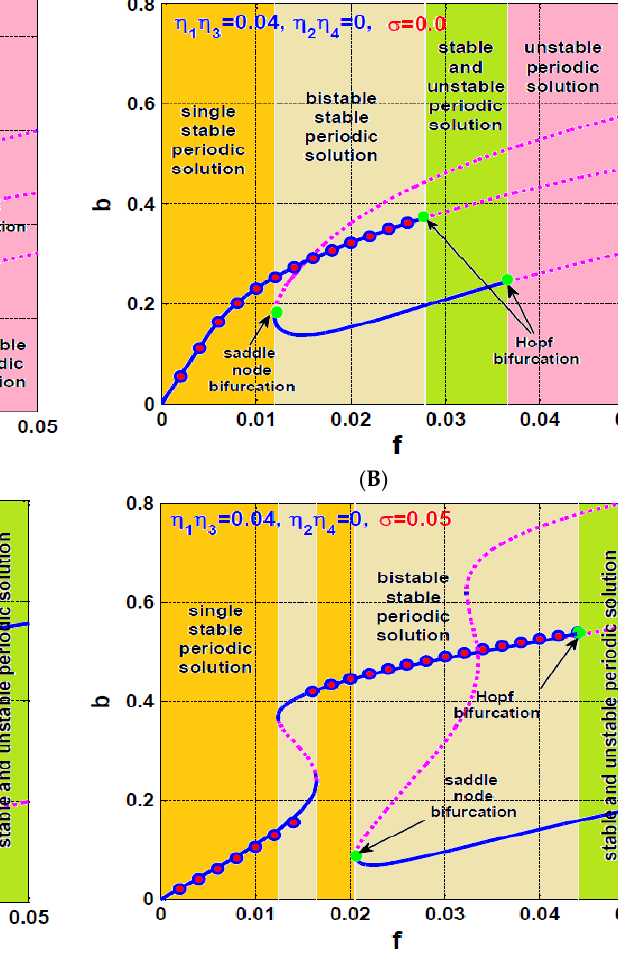
( B ) Figure 10. Stability chart of the rotor system in 𝑓 − 𝜂 1 𝜂 3 plane at two different values of 𝜎 when 𝜂 2 𝜂 4 = 0.0 : ( A ) 𝜎 = 0.0 , and ( B ) 𝜎 = 0.05 .